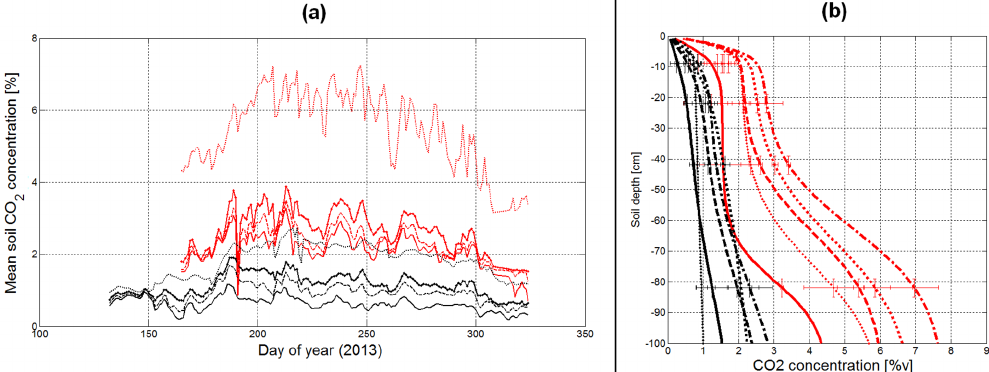
Figure 9. Space-time dynamic of soil CO 2 concentrations at the summit (red) and the footslope (black) position in 2013: (a) time series at different depths; (b) profile at different dates. The legend of the curves in relation to the different depths and dates is given in Fig.